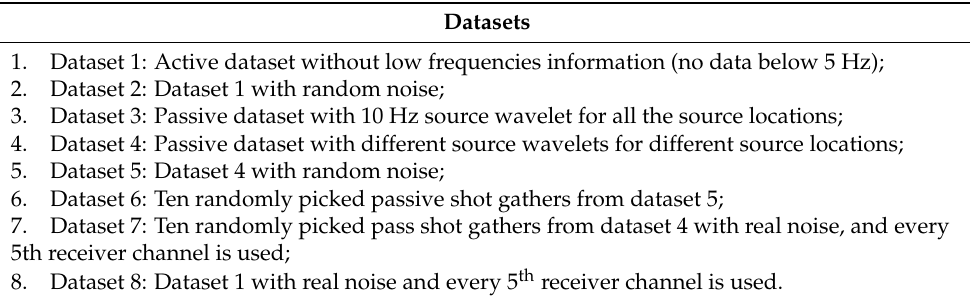
Table 2. The active and passive seismic datasets were generated for the